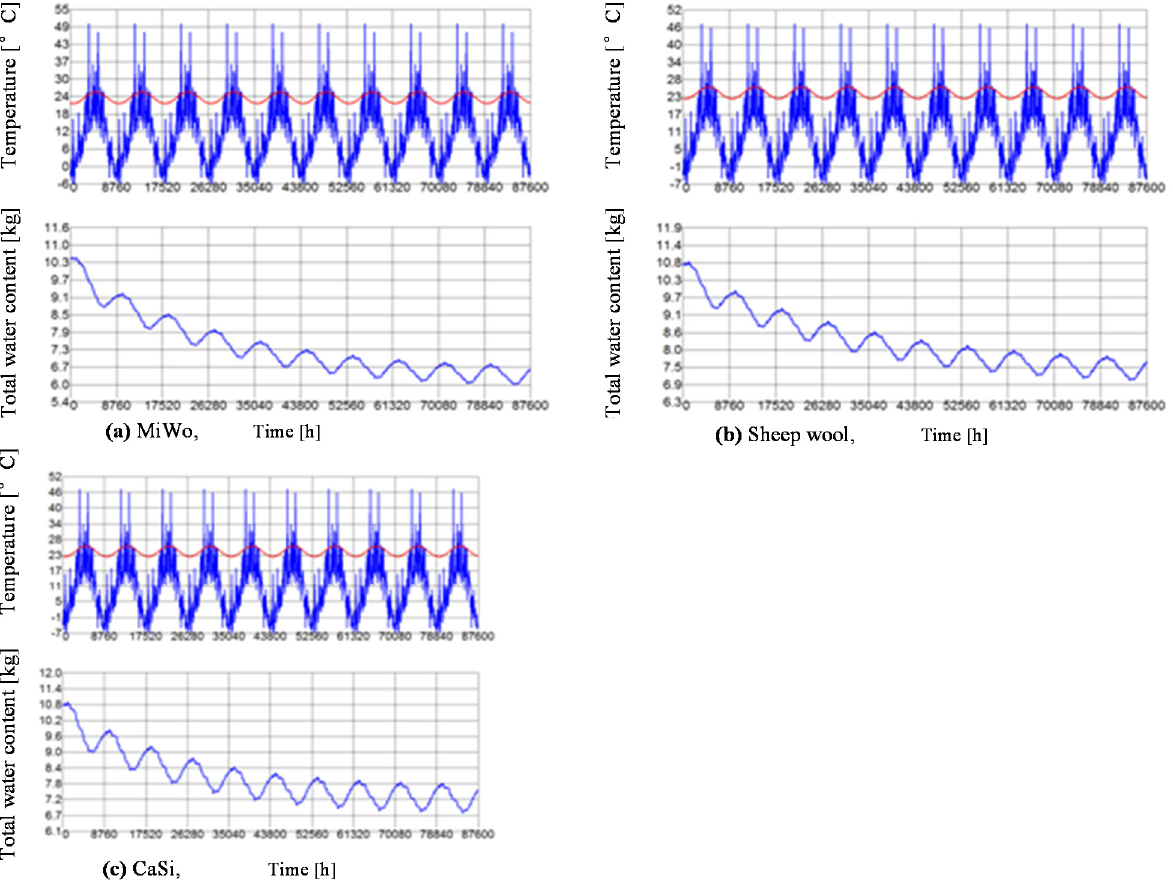
Figure 3. Temperature: exterior (blue), interior (red) and total water content ( a ) MiWo; ( b ) Sheep wool and ( c ) CaSi.